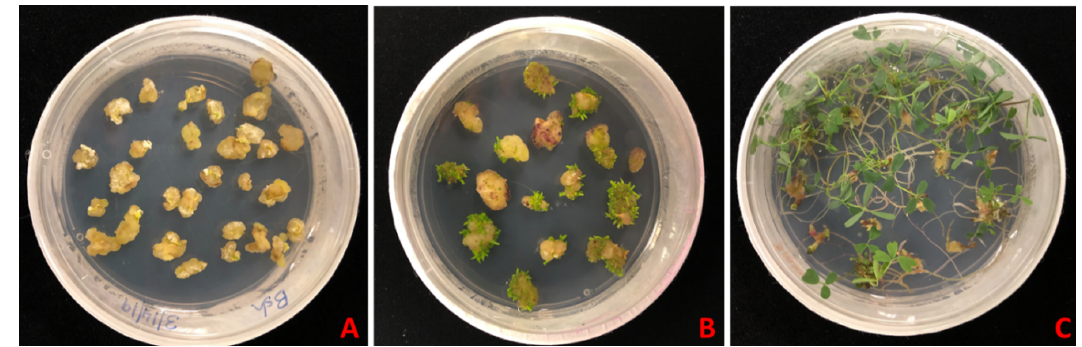
Figure 2. Three phases of somatic embryogenesis observed on the B5h-B5 system. ( A ) Callus induction, ( B ) somatic embryogenesis and maturation and ( C ) embryo germination.